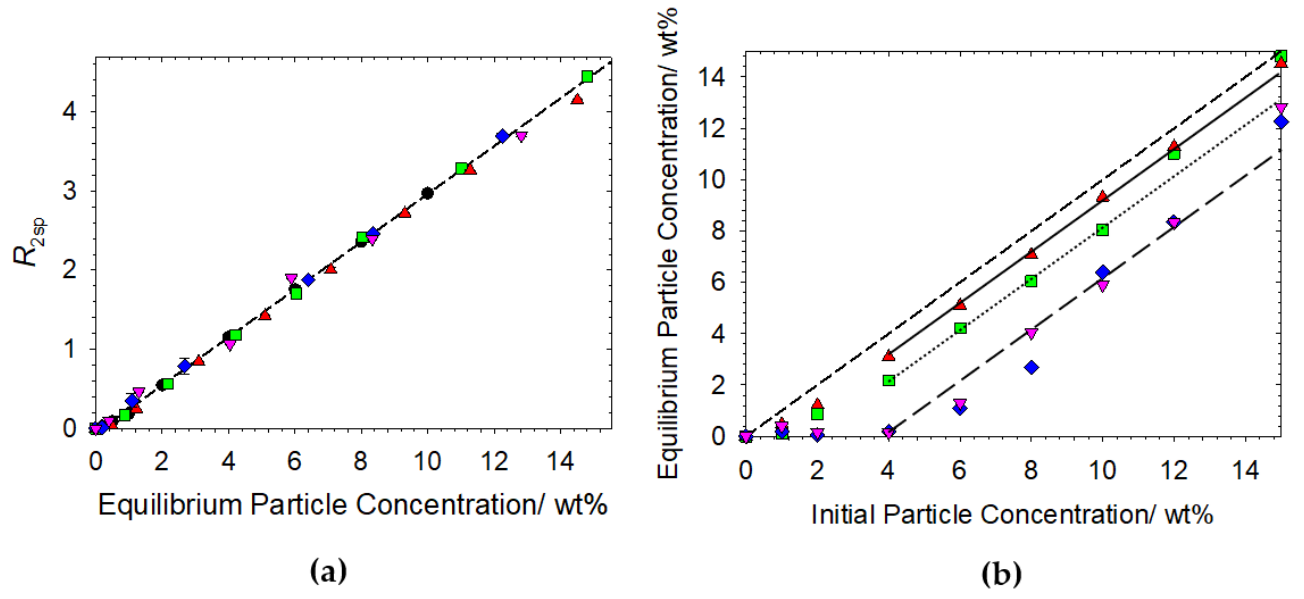
Figure 4. ( a ) Specific relaxation rates as a function of the equilibrium particle concentration for mixtures containing cat-HEC ( n = 0.95%), SDS and Latex. Regression plot is through Latex-only data. ( b ) Equilibrium particle concentration as a function of initial particle concentration for the mixtures. X = Y plot is included as a guide for the eye; dotted and dot dash lines are linear offsets from the X = Y plot. Symbols: ● , Latex only; ▲ , 4 mM SDS + 0.1 wt% cat-HEC polymer (Z = 0.15); ■ , 2 mM SDS + 0.1 wt% cat-HEC polymer (Z = 0.30); ♦ , 0.5 mM SDS + 0.1 wt% cat-HEC polymer (Z = 1.20); ▼ , 0.1 wt% cat-HEC polymer.